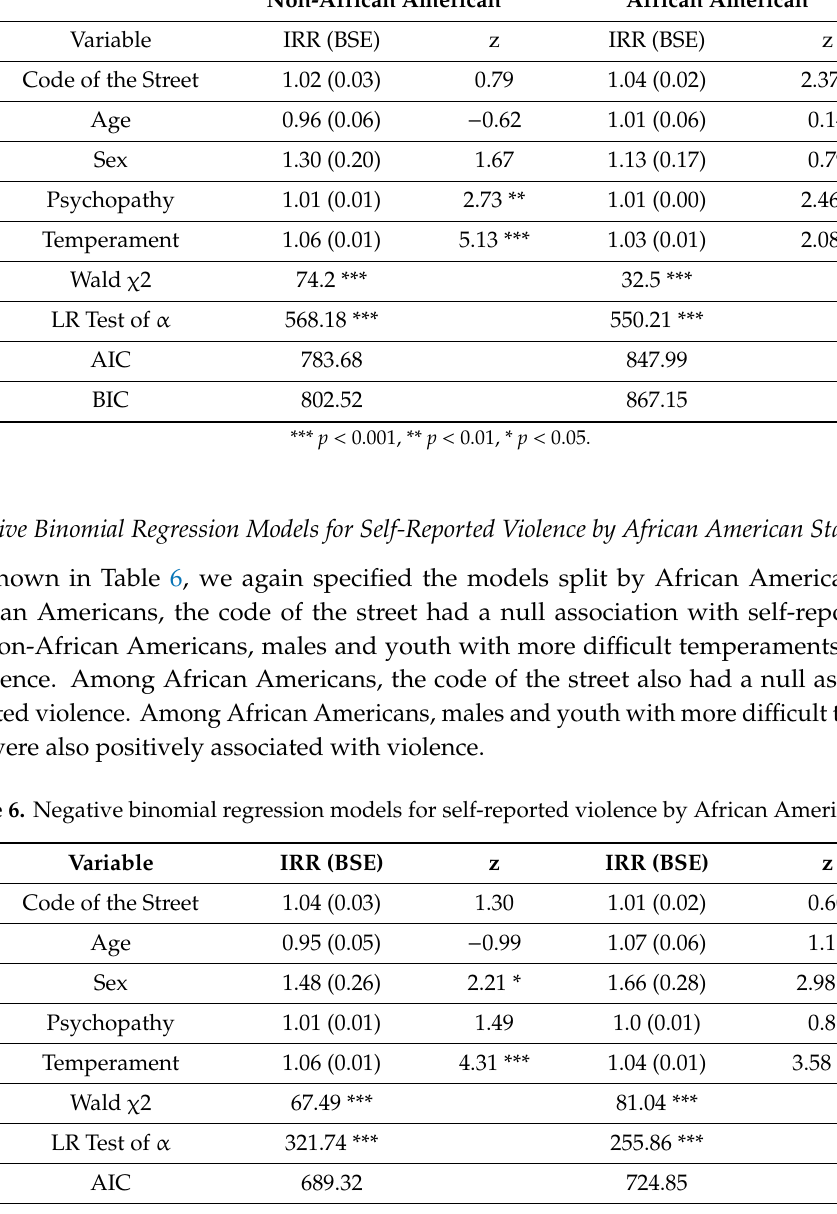
Table 5. Negative binomial regression models for self-reported delinquency by African American status. Non-African American African American Variable